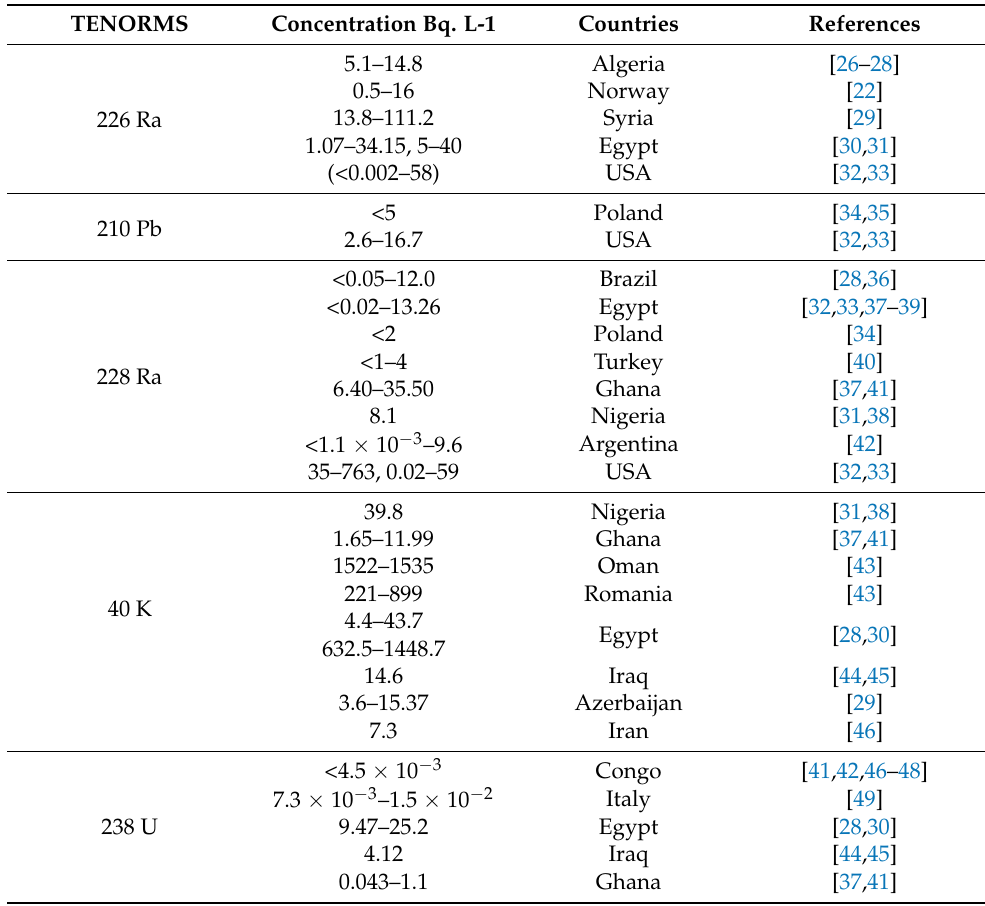
Table 2. Concentration of TENORMS in produced water from oilfields around the